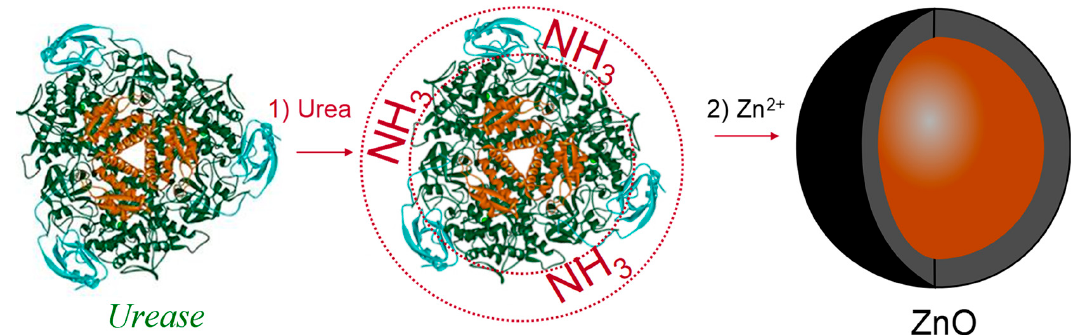
Figure 3. Synthesis of ZnO nanoshells using the urease enzyme as a catalytic template. In the first step, NH 3 is generated by the hydrolysis of urea. This adjusts the pH value around the enzyme. In the second step, Zn 2+ is added. The growth of nanoshells is governed by the local pH value at the enzyme/solution interface (De la Rica and Matsui,